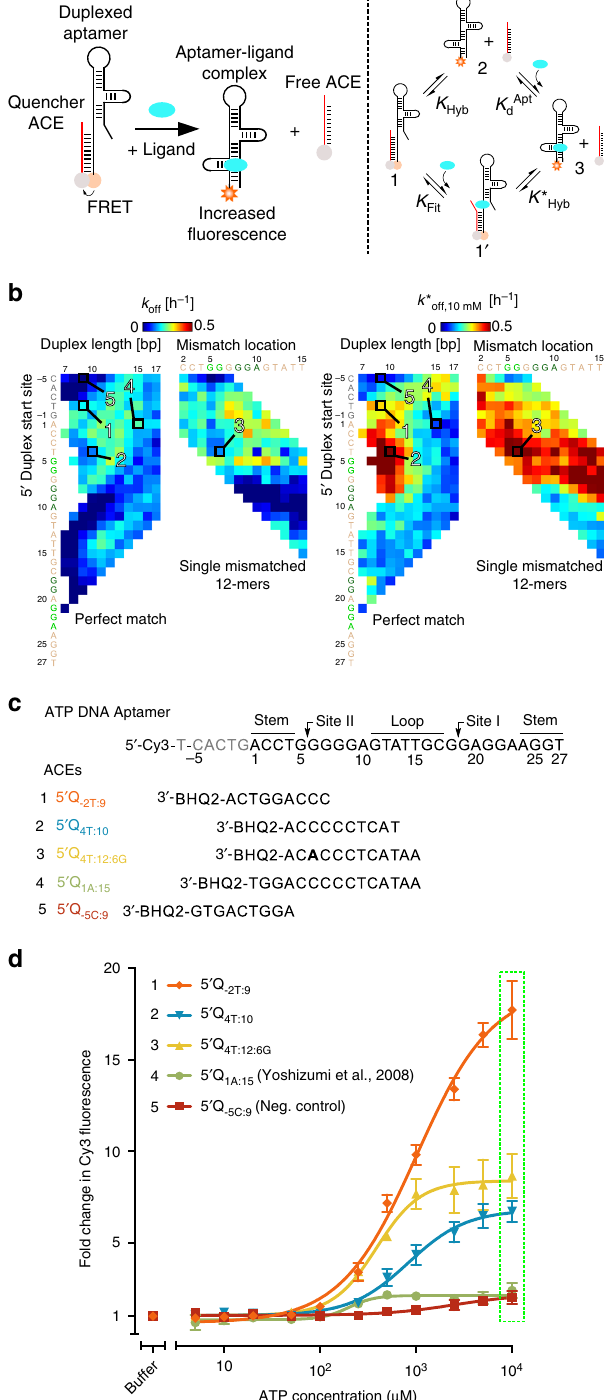
Fig. 3 Validation of ACE-scan with a FRET-based solution-phase assay. Five ATP DNA DAs were re-engineered as FRET DAs and solution-based binding curves were compared to ACE-scan heat map results. a Overview of the solution FRET assay. A four-state, two-pathway thermodynamic cycle (- 1 - 2 - 3 - 1 '-) is shown schematically for solution FRET DAs. b The fi ve tested ACEs are shown schematically as boxed cells on the k off and k * off,10 mM ACE-Scan landscapes (heat maps are truncated from Fig. 2). c Sequences of the fi ve ACE constructs tested. The 5 ʹ Q 1A:15 ACE is adapted from the literature 28 and is representative of the wide variety of published ATP DNA DAs. The mismatched adenosine in the 5 ʹ Q 4T:12:6G ACE is bolded. d Response of solution FRET ATP DNA DA constructs to ligand. Green box highlights the signaling range of DAs to 10 mM ATP. The response of all DAs was in line with their k off and k * off,10mM values measured by ACE-Scan, with (1), (2), and (3) outperforming the 5 ʹ Q 1A:15 DA (4). The negative control 5 ʹ Q -5C:9 DA (5) performed poorly, as expected. Error bars represent one standard deviation (N = 3